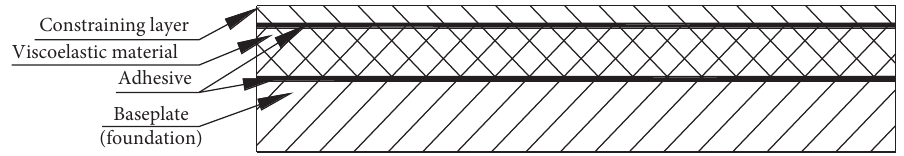
Figure 1: Sketch of sandwich plate.